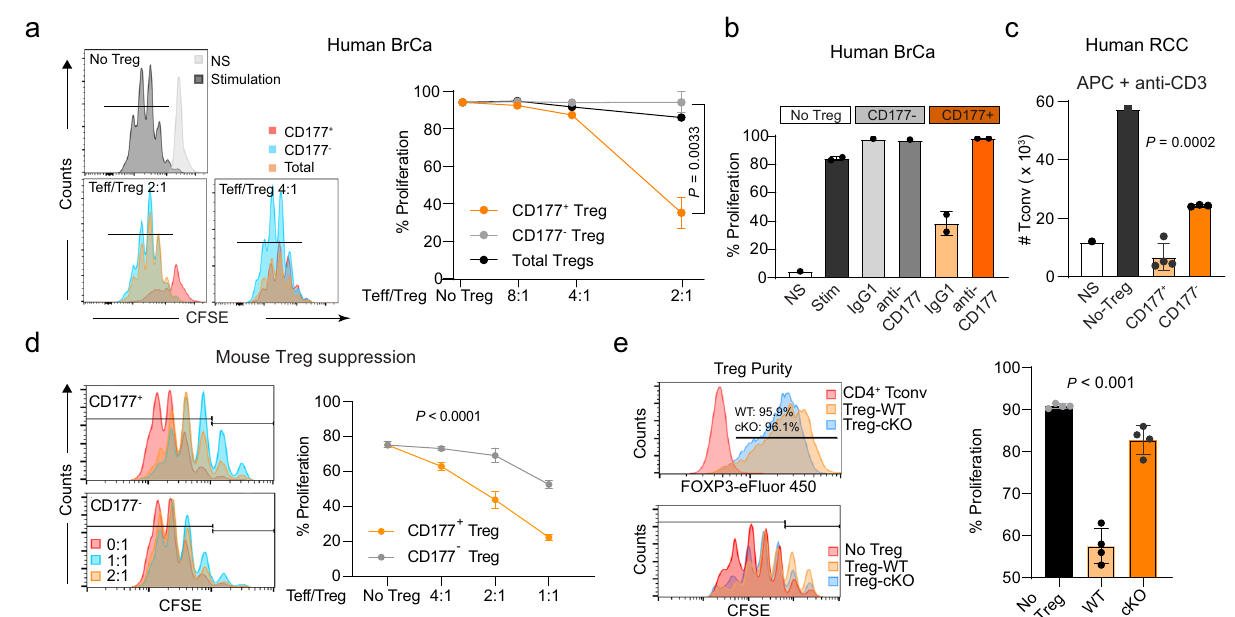
Fig. 7 CD177 + TI Treg cells are highly suppressive to effector T cells. a Suppressive capacity of CD177 + or CD177 − TI Treg cells isolated from breast cancer specimens. CD4 Tconv cells were stimulated by anti-CD3/CD28 co-stimulation. CD4 + CD25 + CD127 low total, CD177 + or CD177 − TI Treg cells were puri fi ed from 3 individual breast cancer specimens and combined for the suppression assay. Left: Histograms showing CFSE dilution peaks indicating Teff cell proliferation and Right: Percentages of proliferative CD4 Teff cells co-cultured with total, CD177 + or CD177 − TI Treg cells at ratios of 2:1, 4:1, 8:1 or no Treg (Combined data from a and b : n = 3 biological replicates for CD177 + TI Treg cells and n = 2 for CD177 − TI Treg cells at 2:1 ratio; n = 1 biological replicate for other data point). P value is for comparison between CD177 + or CD177 − TI Treg cells at 2:1 ratio Teff/Treg, using two-sided T-test. b Impact of CD177 blockade on the immune suppressive function of CD177 + TI Treg cells, using a monoclonal antibody (MEM166). Similar suppression experiments were performed as in a . CD177 + or CD177 − TI Treg cells were puri fi ed from fresh human breast cancer specimens (combined from 5 patients) using fl ow cytometry and co-cultured with effector CD4 T (CD4 + CD25 − ) cells from PBMC for ex vivo suppression assay, with or without the addition of 2 μ g/ml isotype control (IgG) or anti-CD177 antibody (MEM166). Percent of proliferating cells were included and the total number of CD4 Tconv cells were enumerated after 4 days of incubation ( n = 2 biological replicates for CD177 + Treg group, n = 1 for other data points). c Suppressive capacity of CD177 + or